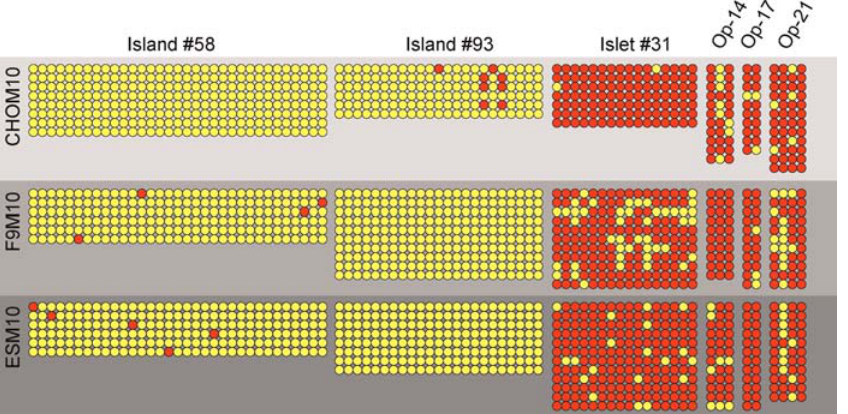
Figure 4. Determination of Possible Variation in DNA-Methylation Pattern owing to Cell-Line Differences The neocentromere-containing M10 chromosome was initially studied in a CHO hybrid cell background but was transferred to a mouse F9 and mouse ES cell line for further testing. DNA methylation was assessed on a selected number of CpG island, islets, and orphans that showed different DNA- methylation levels in the initial assay in CHO. The results indicated no significant difference in methylation levels in all three cell backgrounds. DOI: